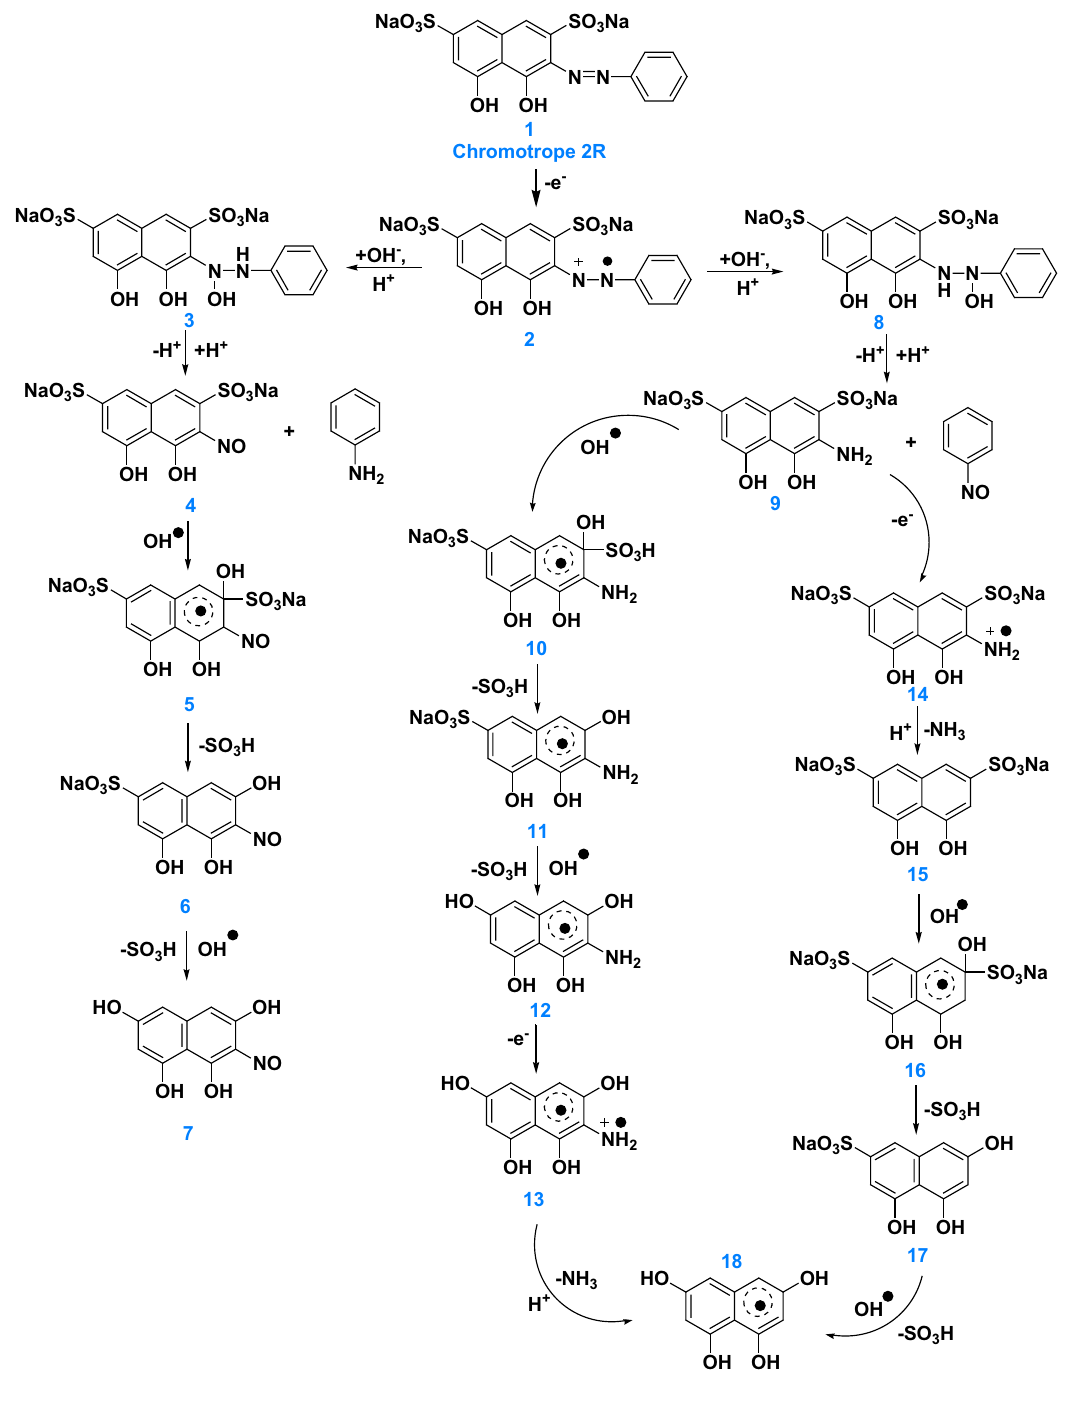
Fig. 9 The possible degradation mechanism of Chromotrope